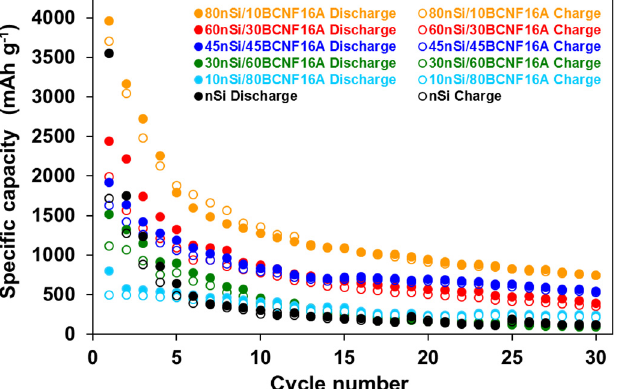
Figure 1. Specific discharge / charge capacity against cycle number plots from the galvanostatic cycling vs. Li / Li + at 100 mA g − 1 of nSi, of 10nSi / 80BCNF16A, 30nSi / 60BCNF16A, 45nSi / 45BCNF16A, 60nSi / 30BCNF16A and 80nSi / 10BCNF16A electrodes, in the 2.1 V–3 mV potential range.